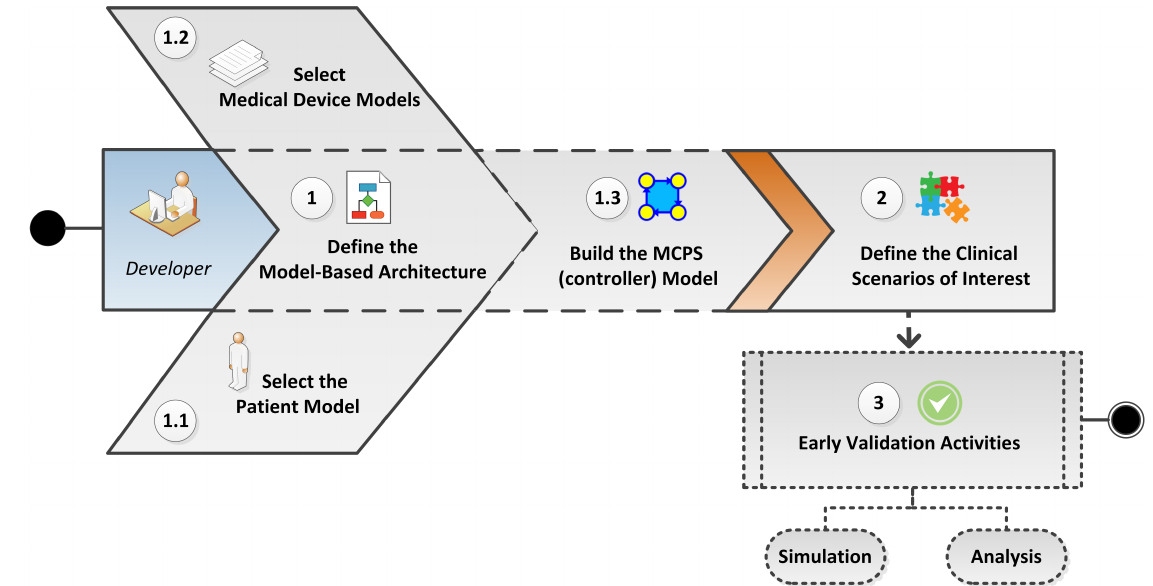
Figure 14. Model-Based Approach for Early Validation of